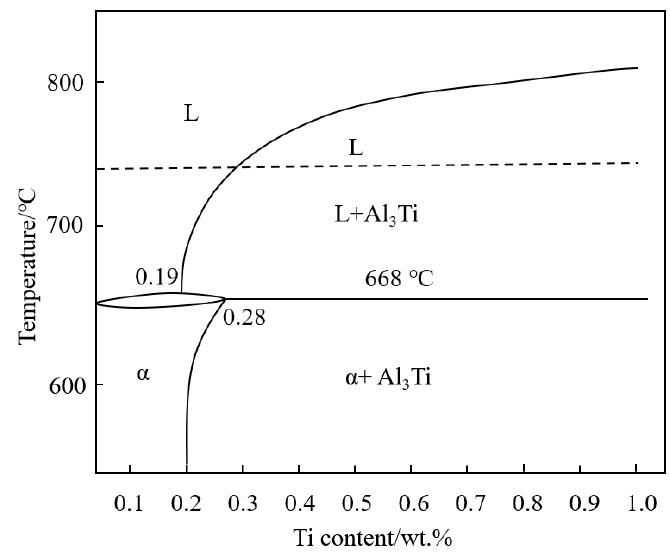
Figure 10. Al-Ti partial phase diagram in the Al-rich side.